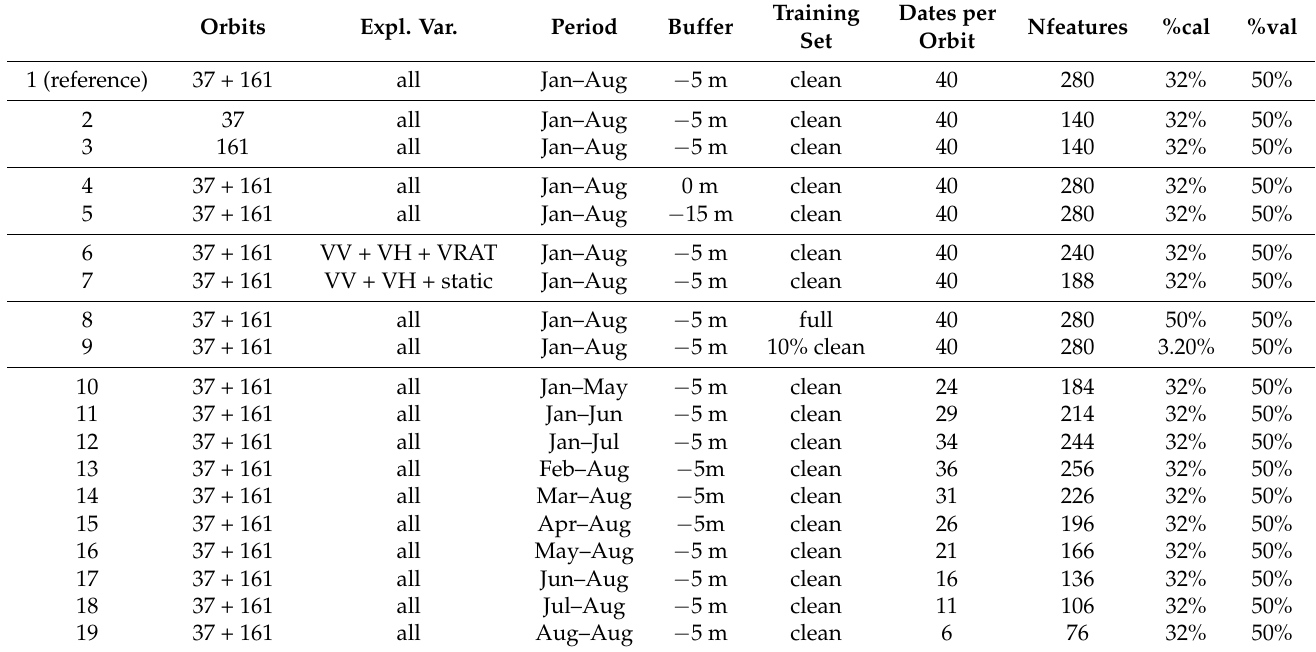
Table 3. Values of the parameters for the different